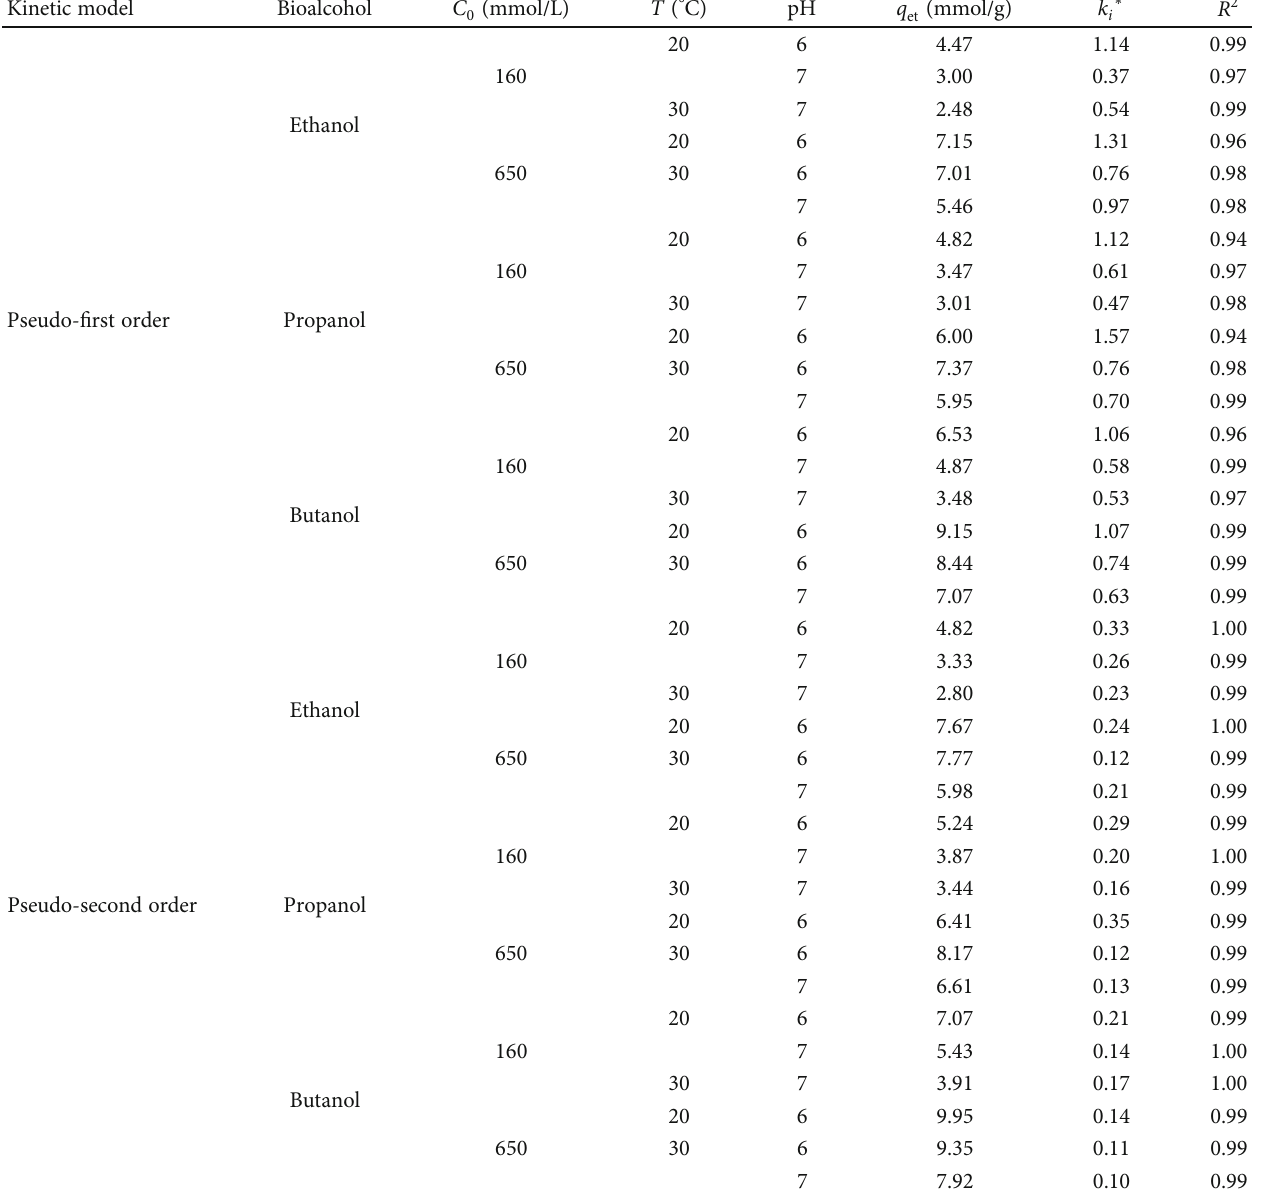
Table 3: Results of the kinetic modeling of adsorption of ethanol, propanol and butanol on bone char. Kinetic